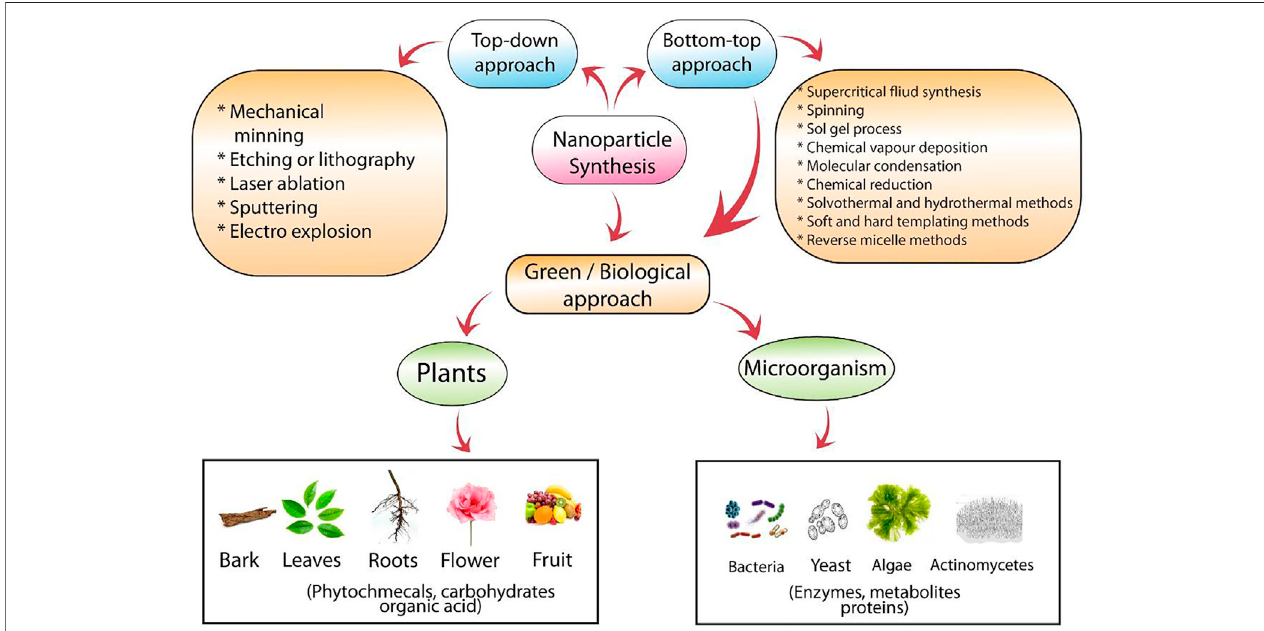
FIGURE 3 | Physical, chemical, and biological approaches for the synthesis of nanoparticles.